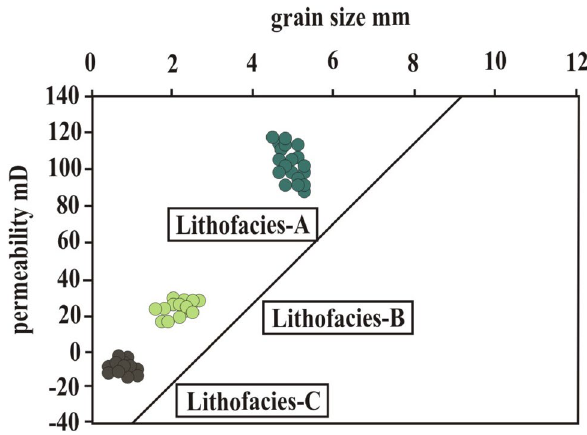
Fig. 13 Cross-plot grain size and permeability of representative sam- ples from the Haymana